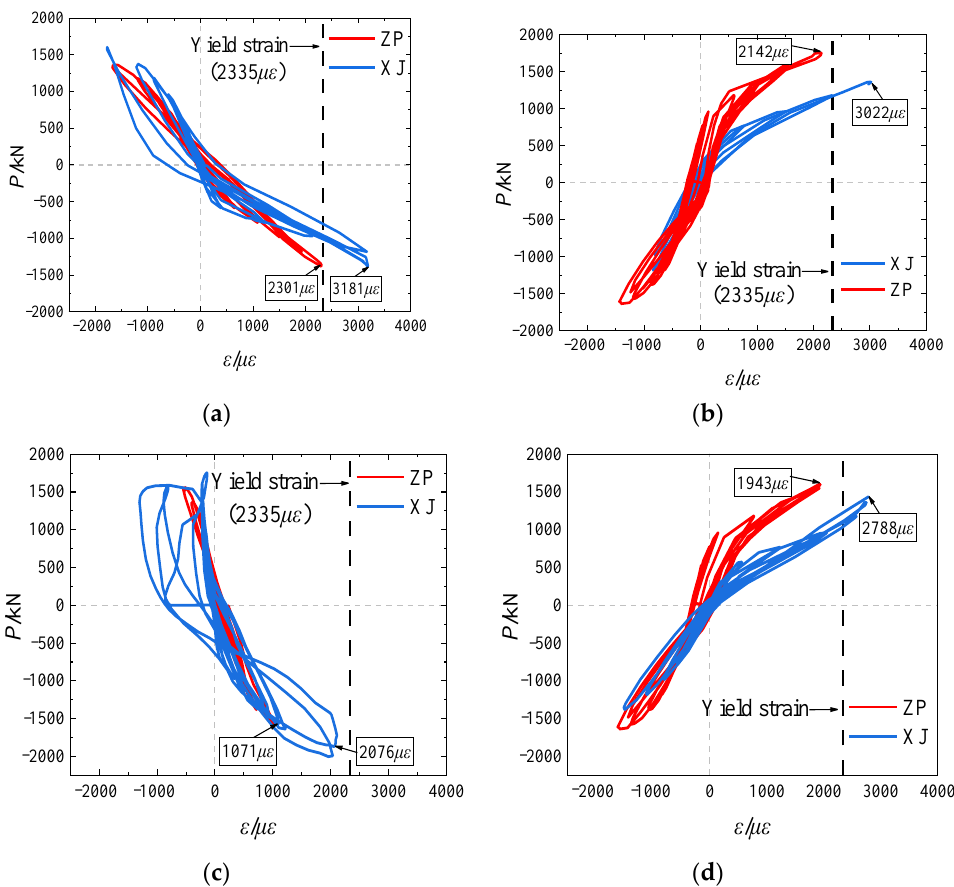
Figure 13. Typical load – strain curves for the steel bars of each specimen. ( a ) Strain of steel bar at S1; ( b ) Strain of steel bar at S2; ( c ) Strain of steel bar at S3; ( d ) Strain of steel bar at S4.